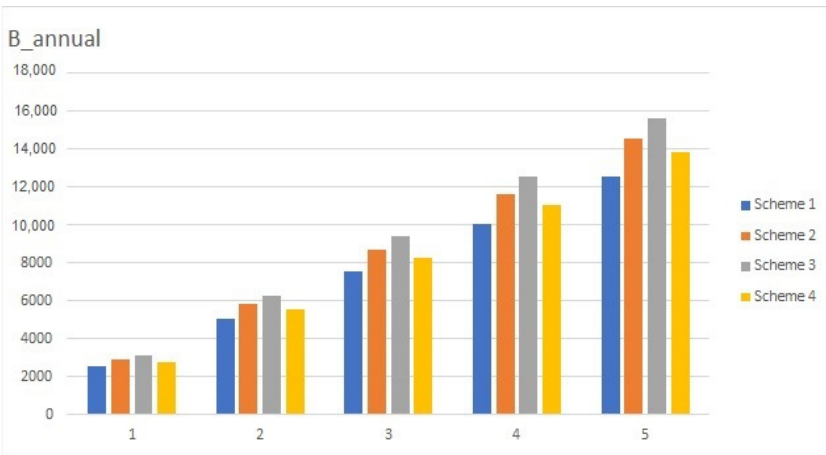
Figure 8. Gross premium size as a function of the lump sum payment.